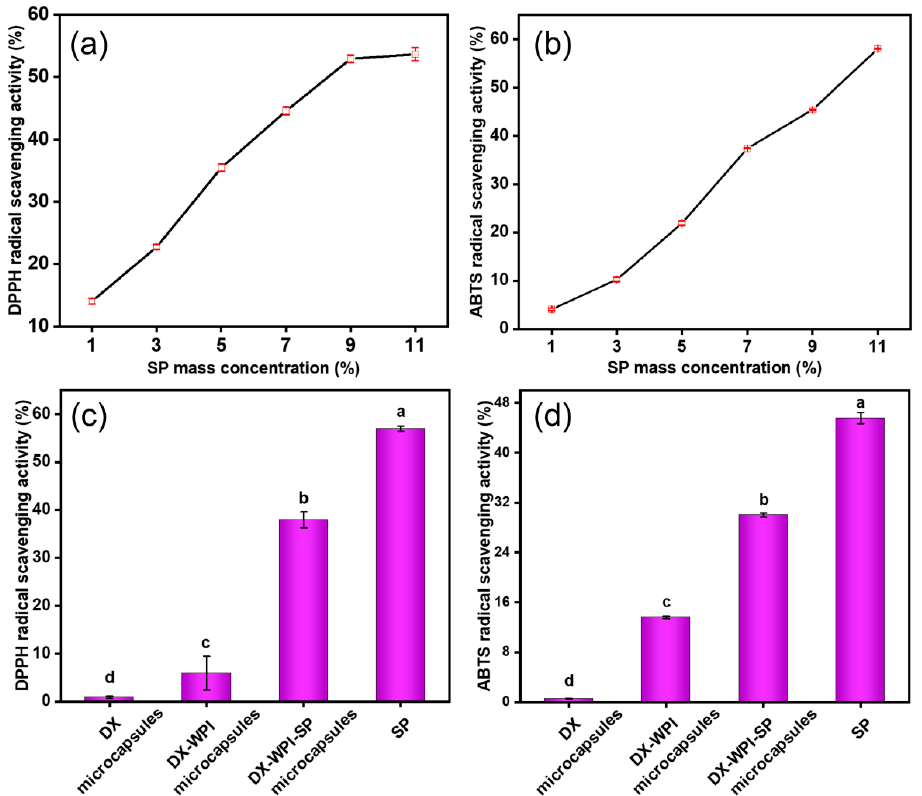
Figure 4. ( a ) DPPH and ( b ) ABTS radical scavenging activity against various SP concentrations. ( c ) DPPH and ( d ) ABTS radical scavenging activity comparisons of DX microcapsules, DX-WPI microcapsules, DX-WPI-SP microcapsules, and SP (all of them were 9%, w / v ). Different letters represent significant differences between columns by Duncan’s test ( p < 0.05).